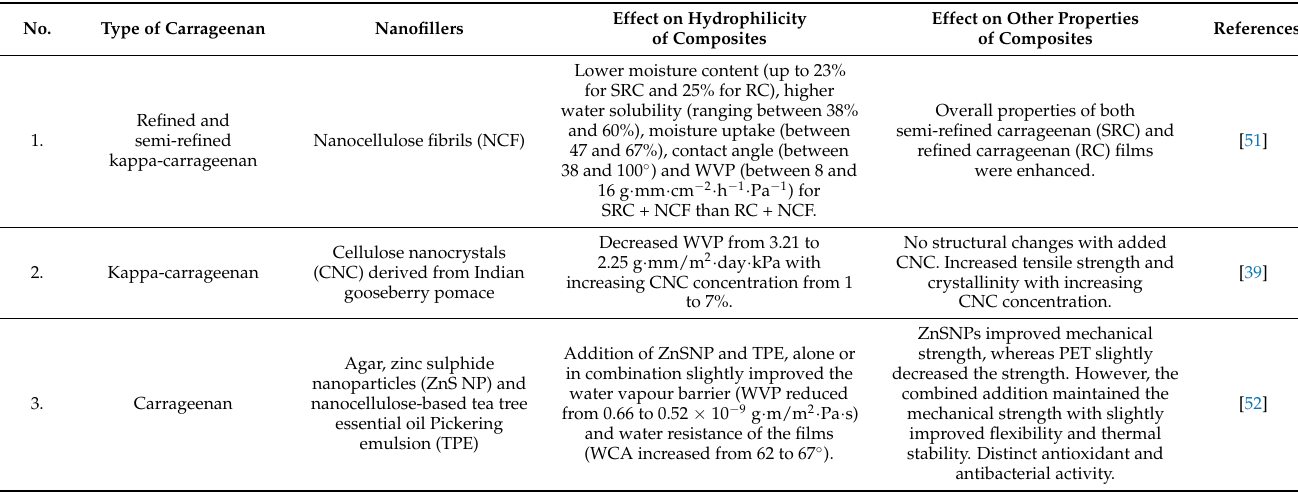
Table 3. Effect of refined vs. semi-refined carrageenan with